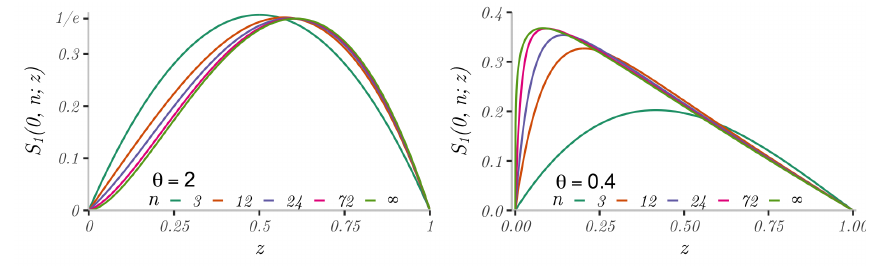
Figure 2. Bernstein polynomials for p k = θ / ( θ + k − 1 )